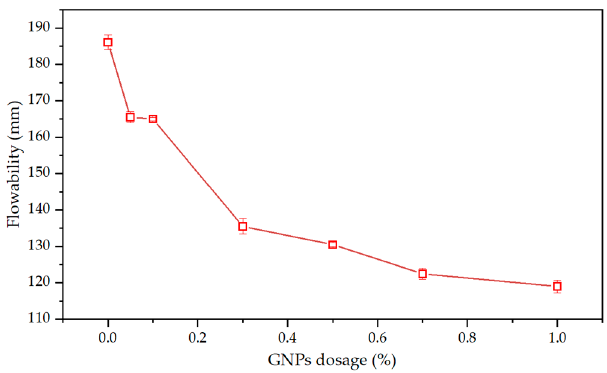
Figure 11. Influence of the GNPs dosage on the flowability of cement mortar.